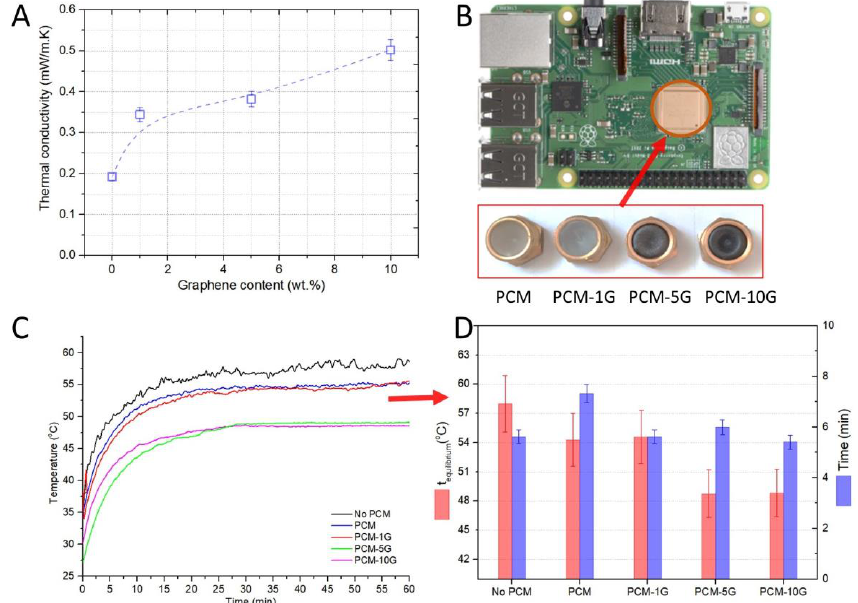
Figure 6. ( A ) Thermal conductivity of the composite samples with different graphene concentrations. ( B ) The Raspberry Pi 3 model B+ motherboard and PCM samples used for thermal buffering. ( C ) The internal temperature of the processor evolution in time shows a significant decrease of up to 10 °C as the graphene content increases. ( D ) The equilibrium temperature and the time required to reach the stable temperature.